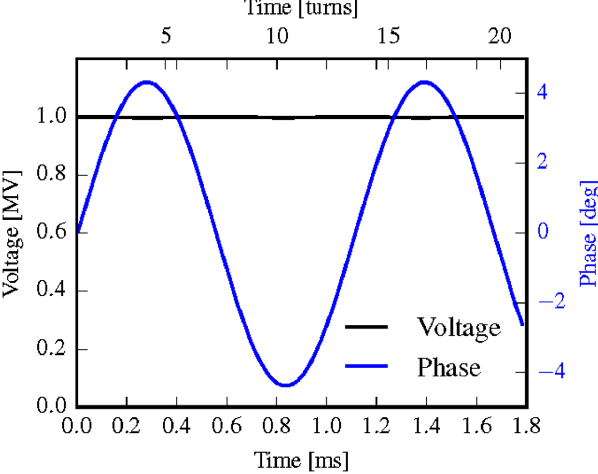
FIG. 6. Plot of the simulated cavity voltage and phase vs time under the influence of microphonics.